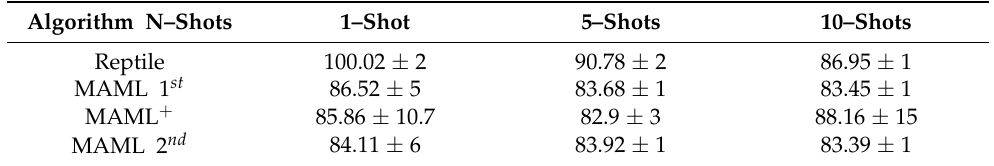
Table 6. Optimization-based experiments comparison, average L ∗ over the last 300 episodes of test tasks T v evaluation, averaged over 3 repetitions with 95% confidence intervals. Algorithm